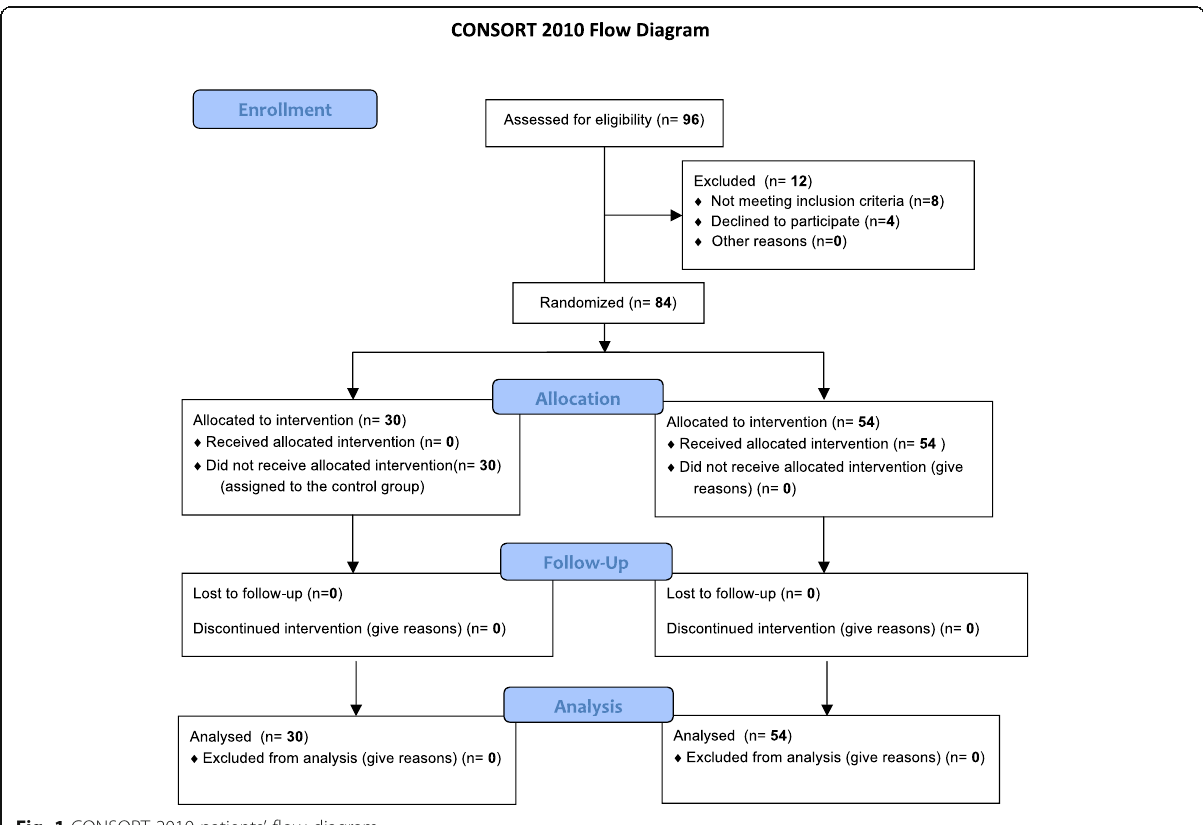
Fig. 1 CONSORT 2010 patients ’ flow diagram